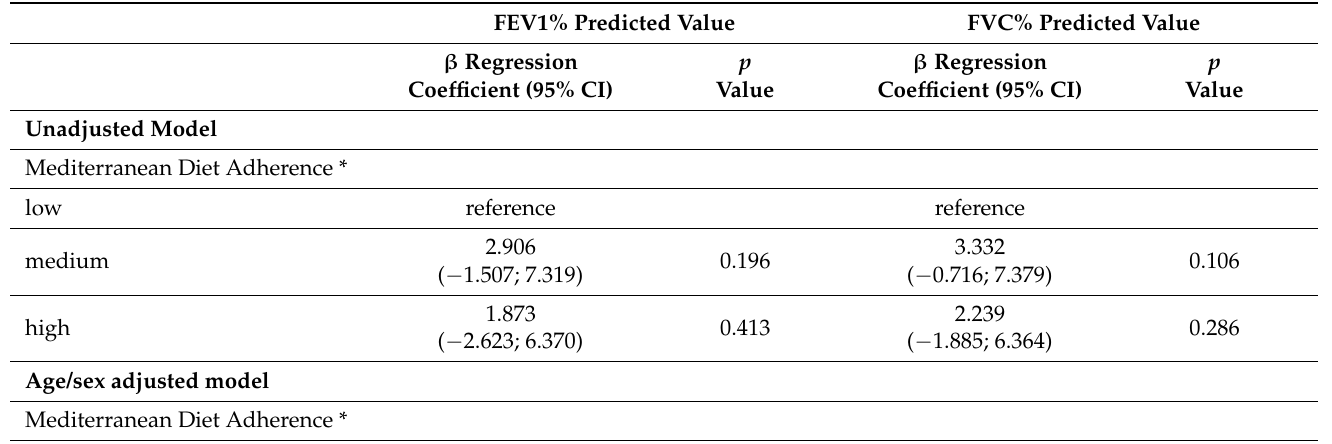
Table 4. Relationship between Mediterranean Diet Adherence Group and impaired FEV1% and impaired FVC% predicted